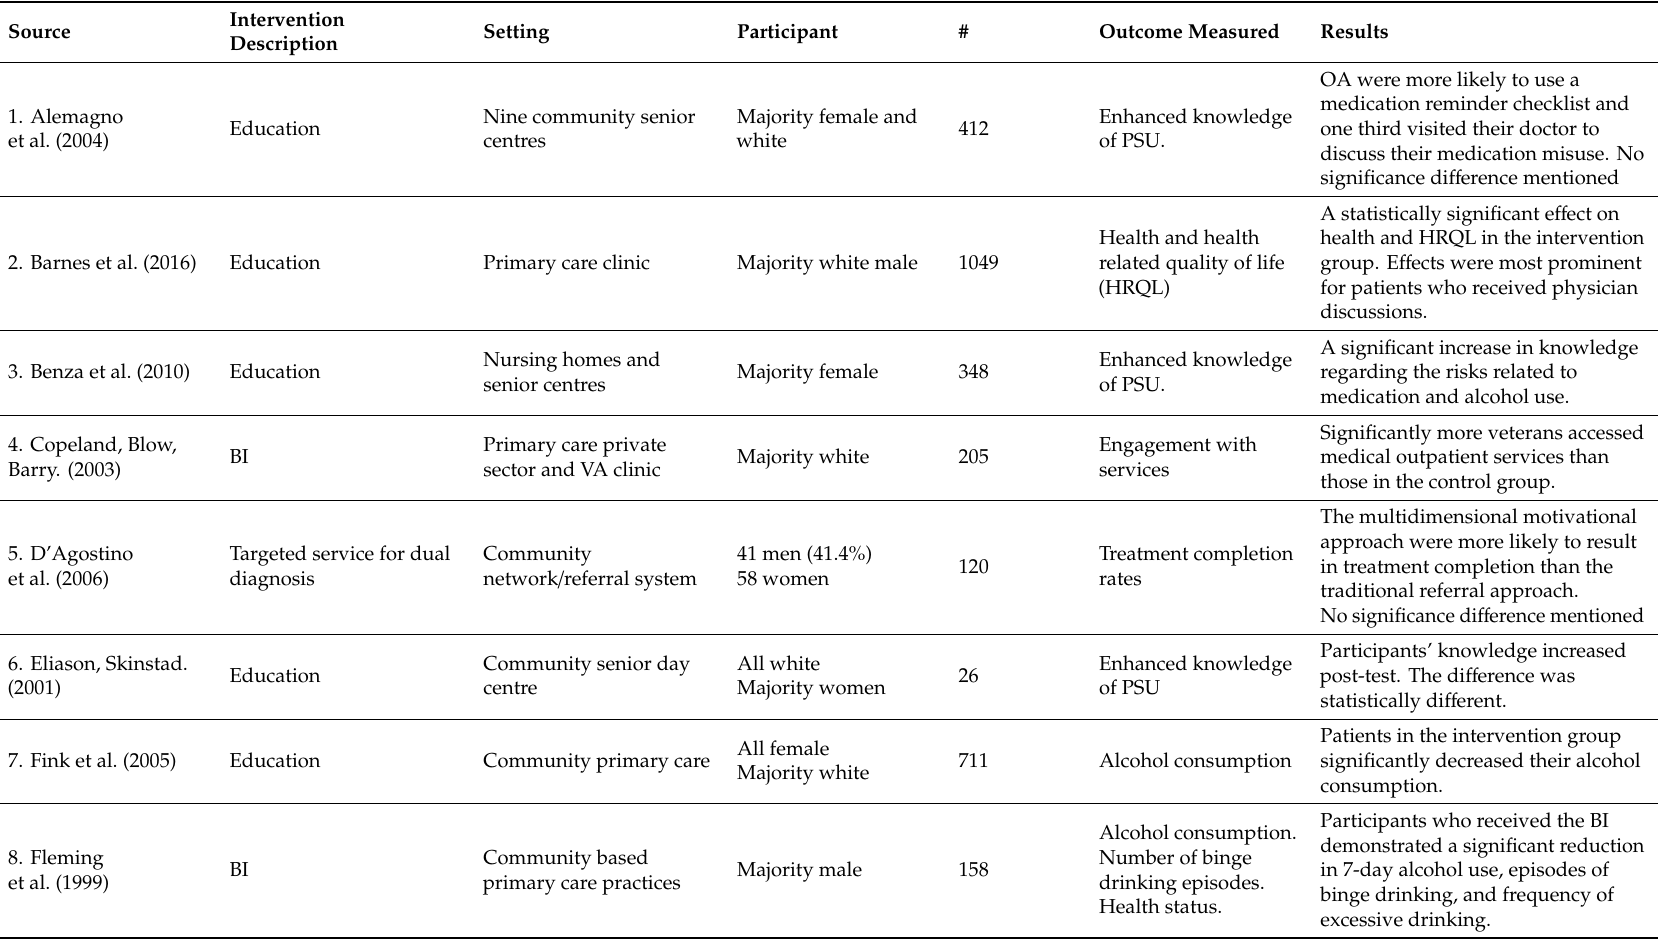
Table 4. Study interventions and outcomes